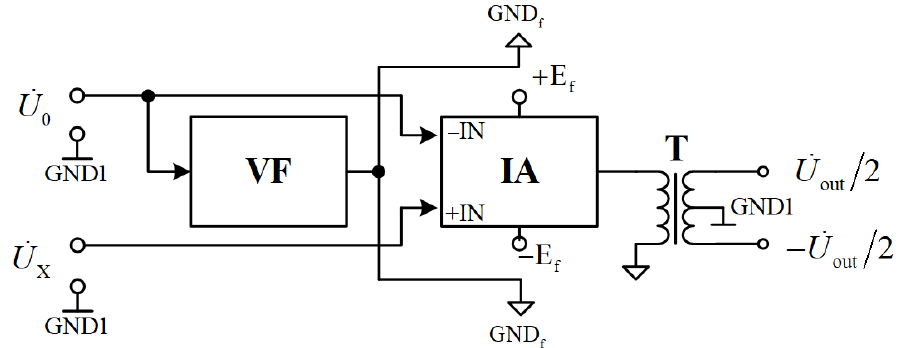
Figure 2. Schematic circuit of differential signal recovery.